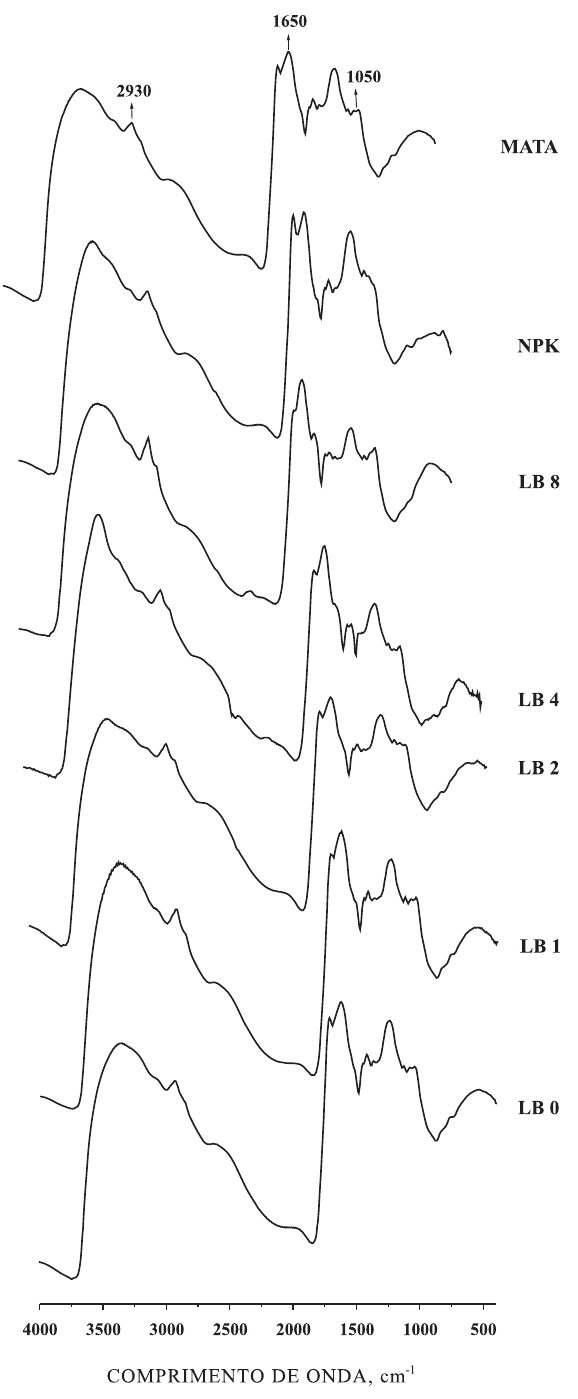
Figura 2. Espectros de infravermelho dos ácidos húmicos de Latossolo sob efeito de doses crescentes de lodo de esgoto; LB0, LB1, LB2, LB4 e LB8 (0, 1, 2, 4 e 5 vezes a necessidade de N do milho) e área sob mata e adubação mineral